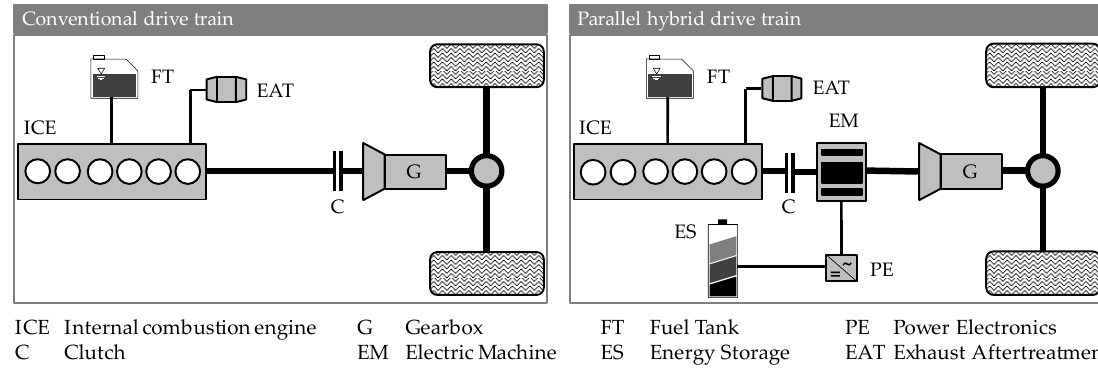
Figure 1. The product system studied.